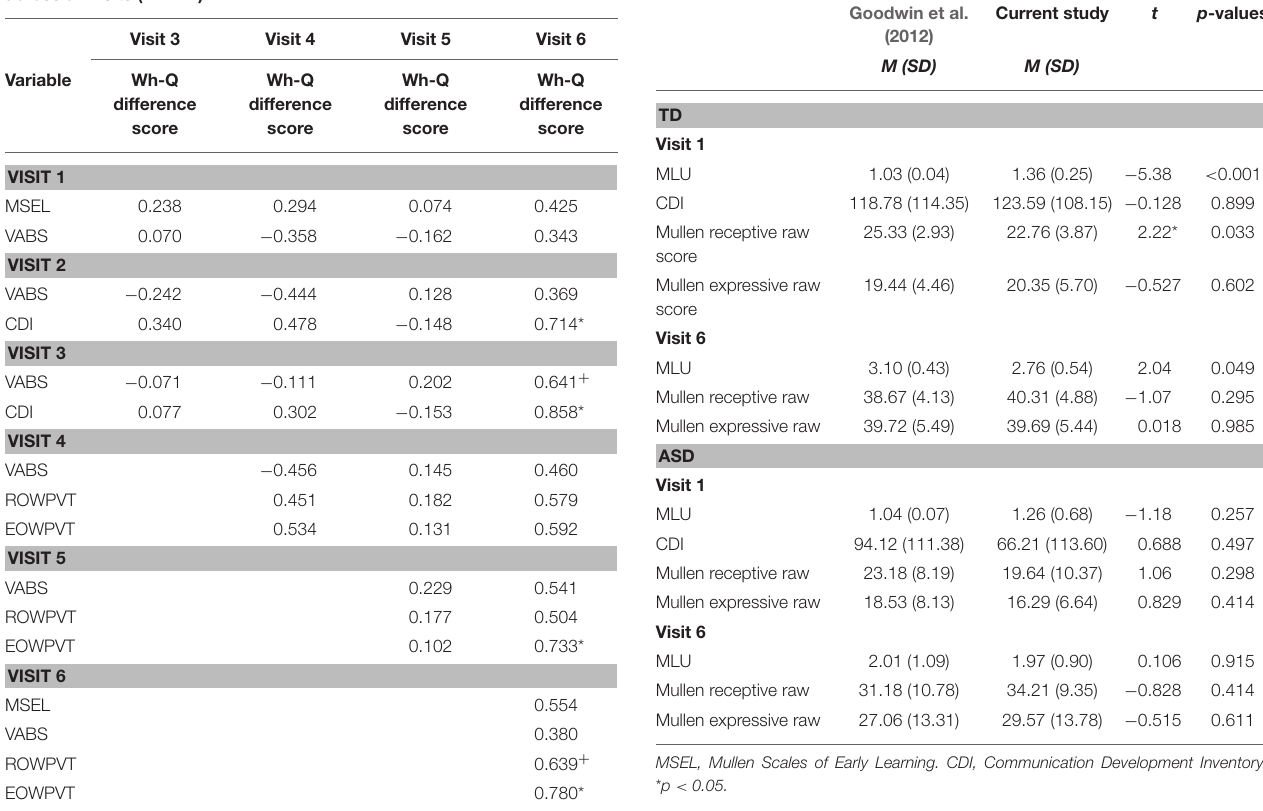
TABLE 5 | Cross-lagged and concurrent pearson correlations between language measures and Wh-question comprehension for TD children across all visits ( N = 17).